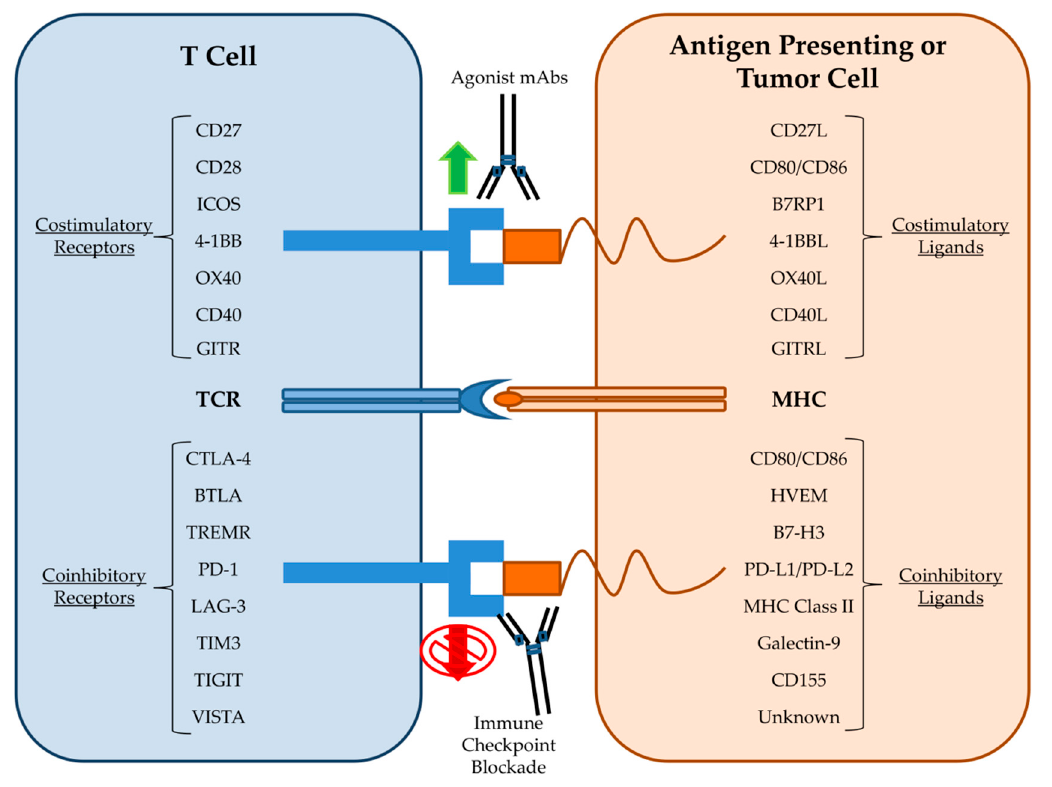
Figure 2. Immune checkpoint targets of monoclonal antibodies.